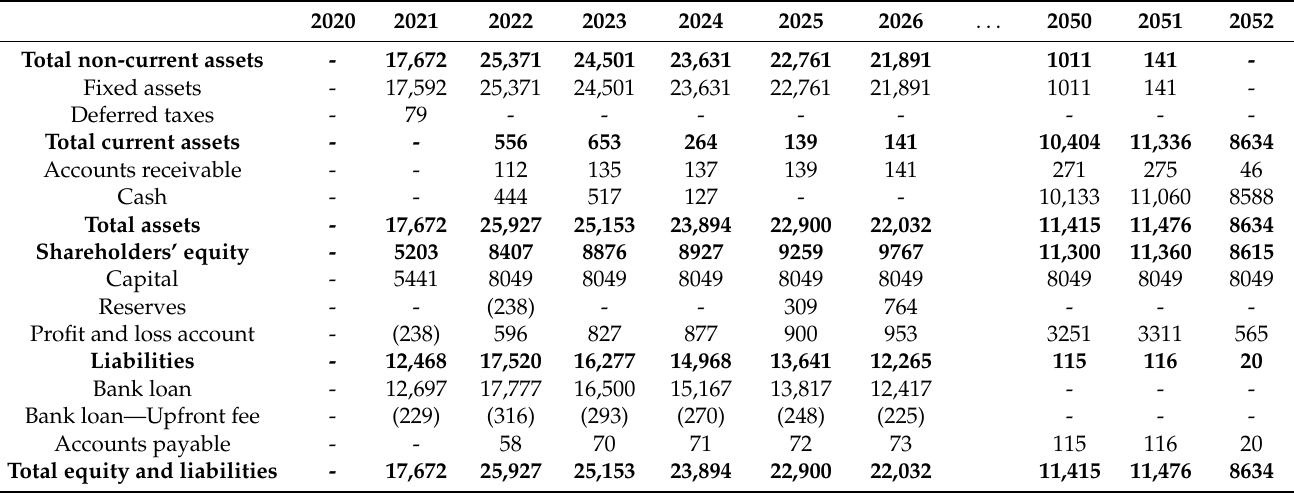
Table 3. Pro forma balance sheet for the base